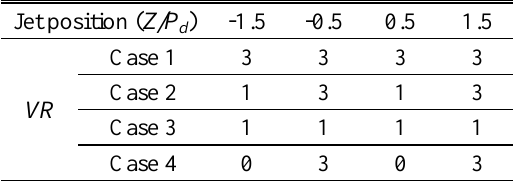
Table 1 VR condition in synthetic jet array.